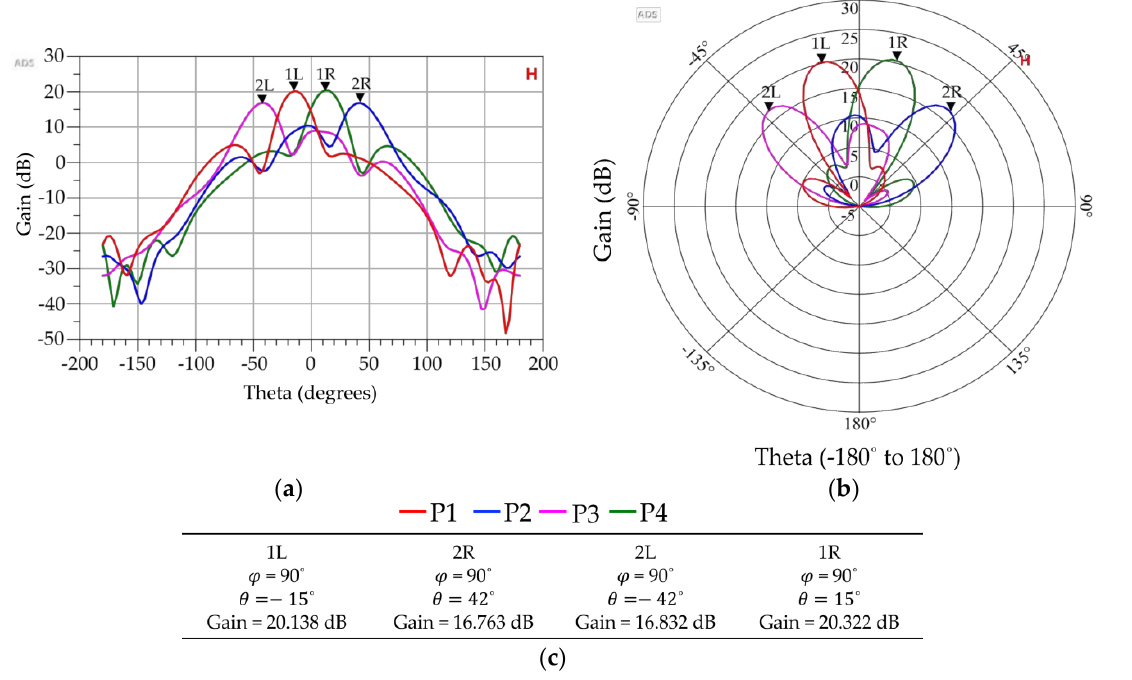
Figure 21. Three dimensional FEM simulated radiation patterns generated by ADS. ( a ) Radiation patterns in rectangular coordinates when beam ports 1L, 2R, 2L, and 1R are excited individually, ( b ) Radiation patterns in polar coordinates when beam ports 1L, 2R, 2L, and 1R are excited individu- ally, ( c ) Corresponding parameters values of respective beam